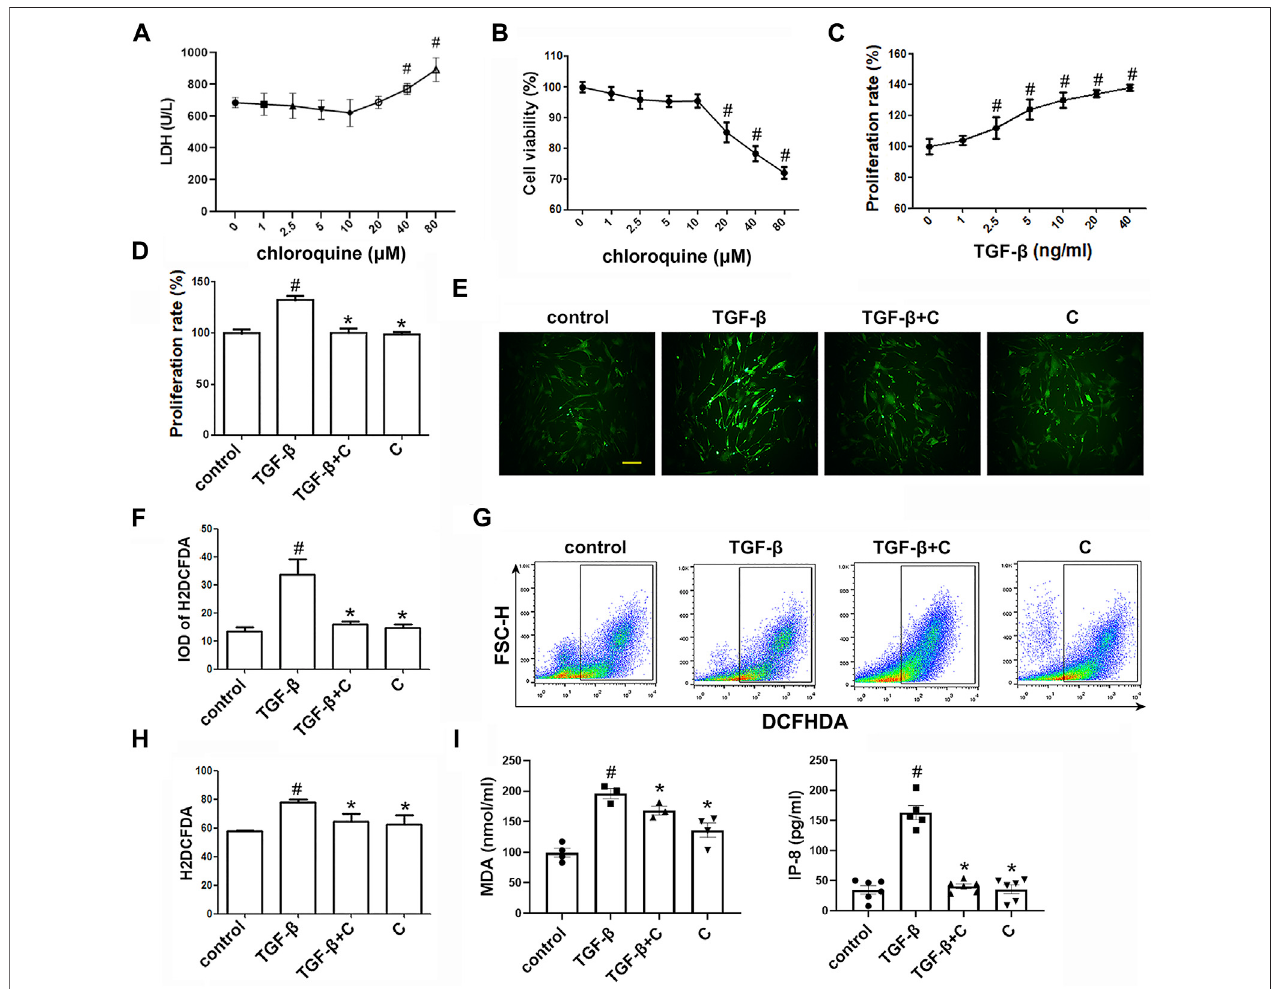
FIGURE 3 | Treatment with chloroquine inhibited ASM cell proliferation, ROS generation and MDA/IP-8 production elicited by TGF- β 1 (A) Cytotoxicity of chloroquineinhumanASMcells(LDHassay) (B) Cellviabilitywithdiverseconcentrationsofchloroquine(CCK-8assay) (C) CellproliferationprovokedbyTGF- β 1(CCK-8 assay) (D) Inhibition of TGF- β 1-stimulated cell proliferation by chloroquine (E,F) DCFH-DA fl uorescence (green) imaging of ROS with a laser scanning confocal microscope (magni fi cation, ×400; scale bar, 50 µm) (G,H) Fluorescence-activated cellsorting pro fi le ofROS with DCFH-DA by fl owcytometry (I) Analysisfor MDA and IP-8 content in supernatant. Values are the mean ± SEM of at least four independent experiments performed in triplicate. # p < 0.05 compared with the control, and * p < 0.05 compared with the TGF- β 1 group. C, chloroquine (5 μ m); TGF- β , TGF- β 1 (5 ng/ml).